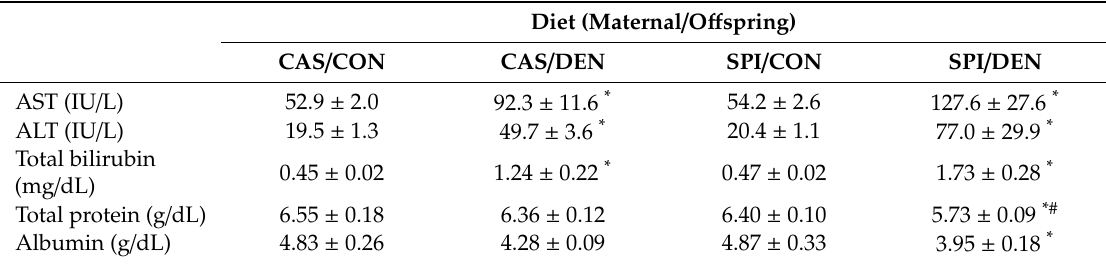
Table 2. E ff ects of maternal diet on serum biochemical parameters of DEN-treated male rat o ff spring. Diet (Maternal / O ff